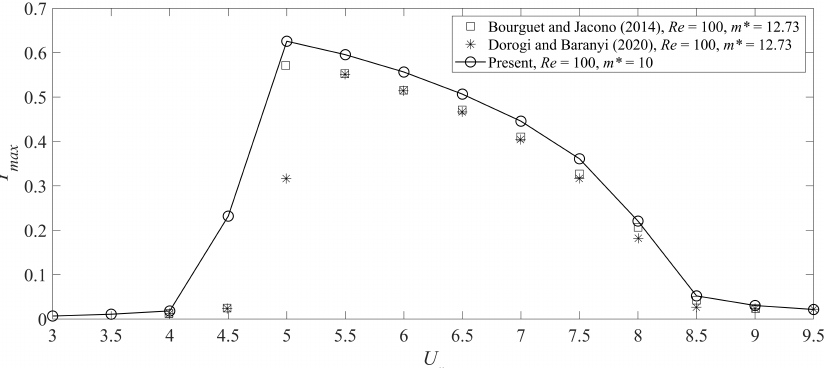
Figure 6. Comparison of numerical results between the present study and previous numerical investigations (Bourguet and Jacono [44], Dorogi and Baranyi [45]) for the normalized maximum transverse displacement Y max as a function of the reduced velocity U r . The current numerical simulations are of the VIV response of a circular cylinder for Re = 100, m ∗ = 10, and ζ = 0. The resolution of U r used in present simulations is 0.5.